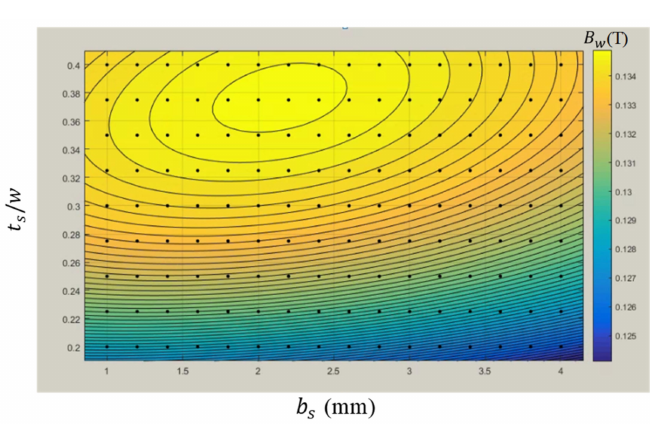
Figure 17. Contour map of B w varied with b s = 1–4 mm and t s /w =